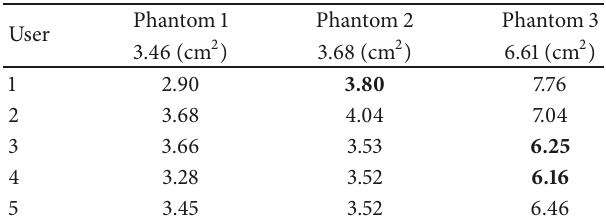
Table2:Imageacquisitionbyrandomusers(notclinicians)inorder